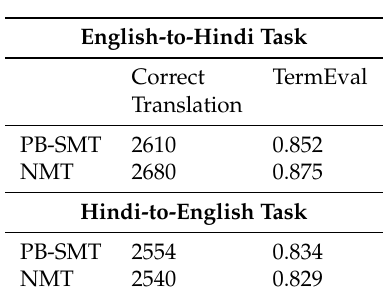
Table 5. Terminology translation accuracy in TermEval.